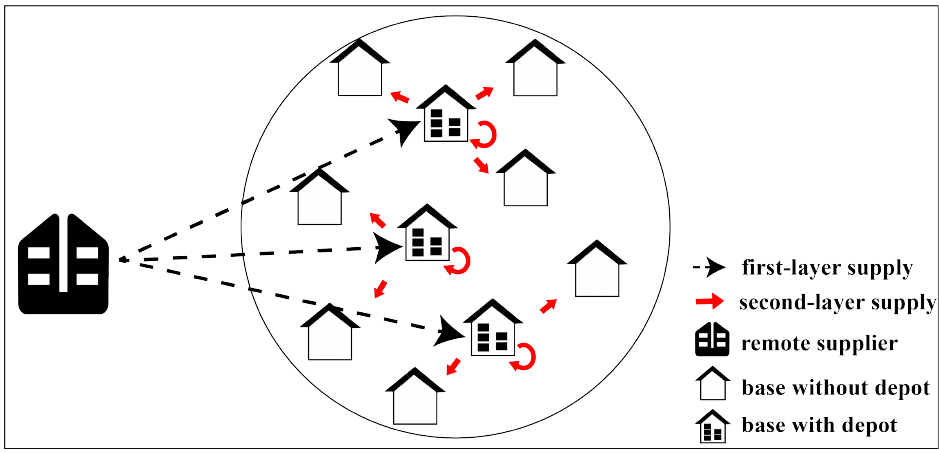
Figure 1. The framework of a three-echelon supply chain with product and information